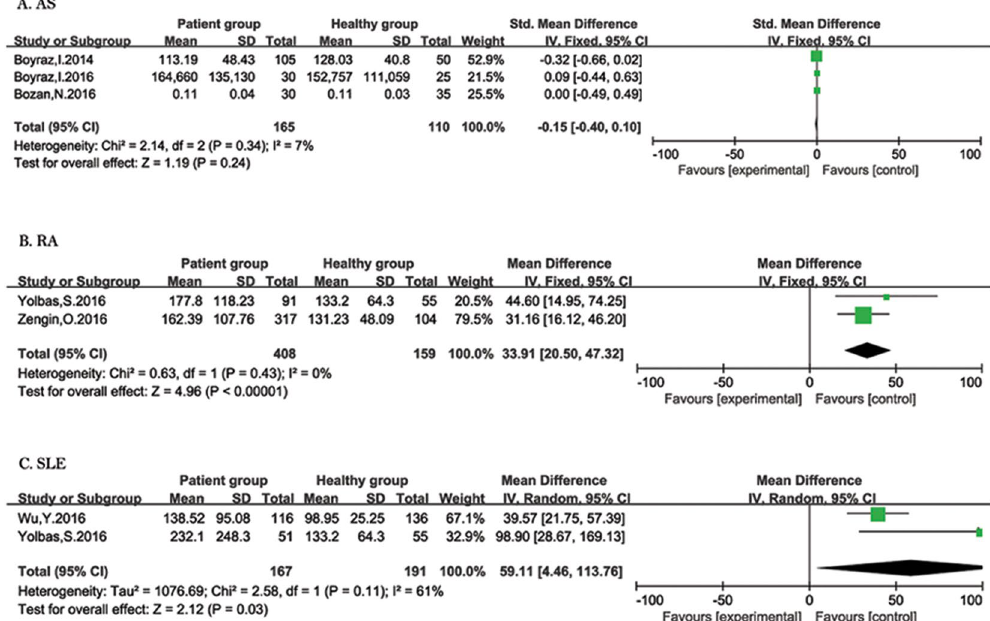
Figure 3. Forest plot of relationship between PLR and ARDs. AS ( A ), RA ( B ), and SLE ( C ).